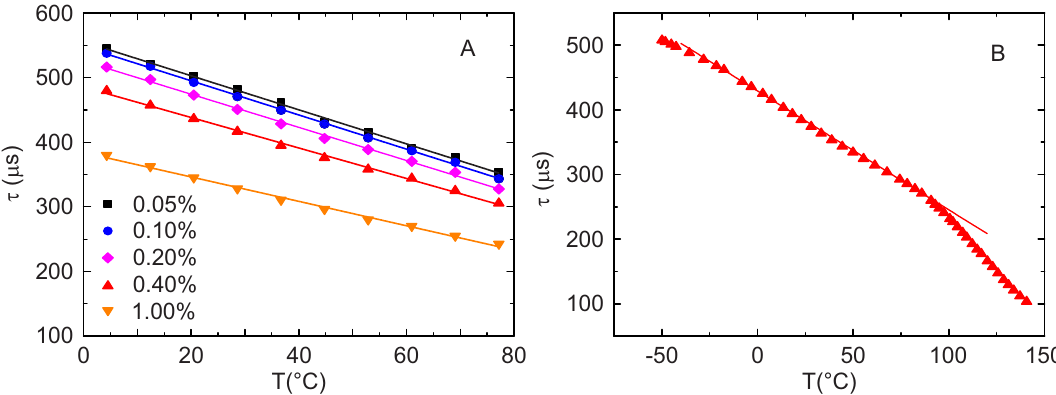
Figure 7. ( A ) Temperature dependence of the monoexponential lifetime for samples with different Mn 4 + doping concentrations; ( B ) Temperature dependence of a sample with 0.40% doping concentration in a broader temperature range obtained in the frequency domain. Points: Measurements, solid lines: linear fit. In B, the linear fit is performed in the temperature range from − 30 ◦ C to 80 ◦ C.